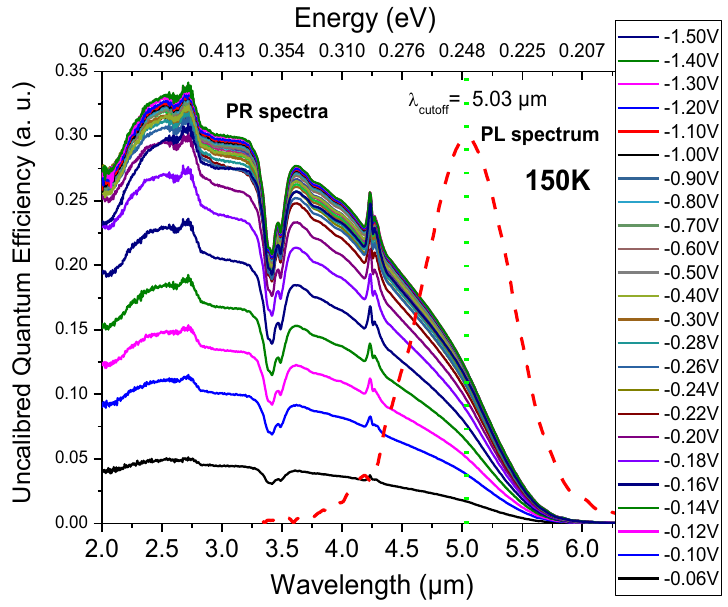
Figure 9. Photoresponse (PR) at different biases and photoluminescence (PL) measurements at 150 K.